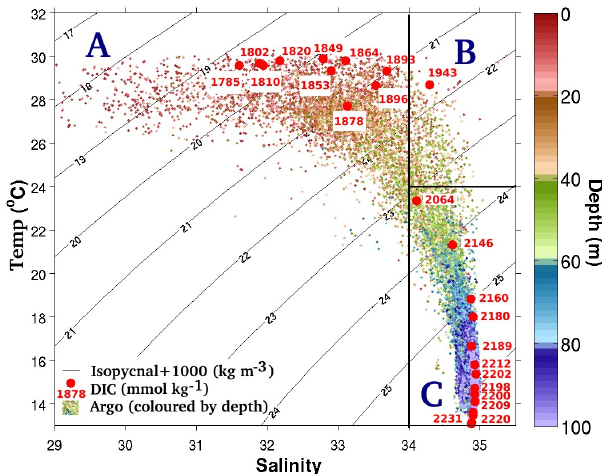
Figure 2. The total library of Argo profiles collected within the ETPO in the upper 100m. Numbered red dots indicate the total dissolved carbon concentration at specific T S values as measured during the WOCE cruise